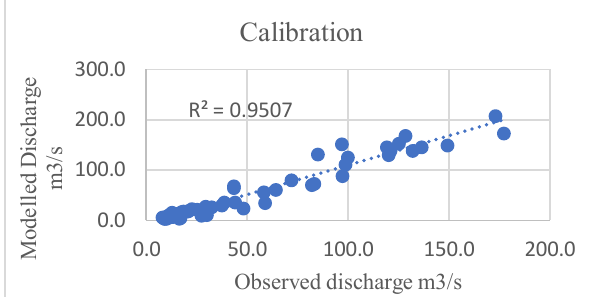
Figure 4. Comparison of Observed and Simulated monthly flow for calibration